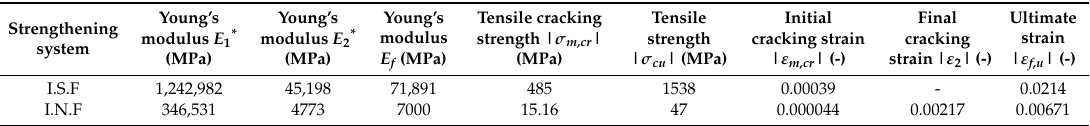
Table 3. Mechanical properties of strengthening systems (homogenized to fiber section): inorganic synthetic fiber-based (I.S.F) and inorganic natural fiber-based (I.N.F.). Both specimens are made of bi-directional fiber grids.